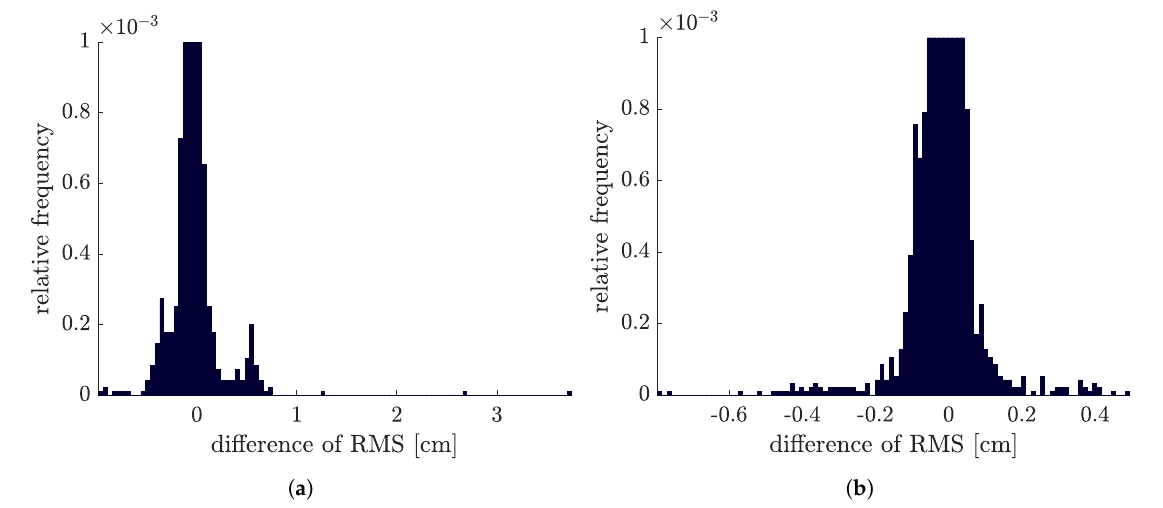
Figure 7. Difference of RMS values of the deformation time series estimated with ( a ) the conventional EMCF approach minus RMS of one-step three-dimensional approach and ( b ) the alternative EMCF approach minus RMS of one-step three-dimensional